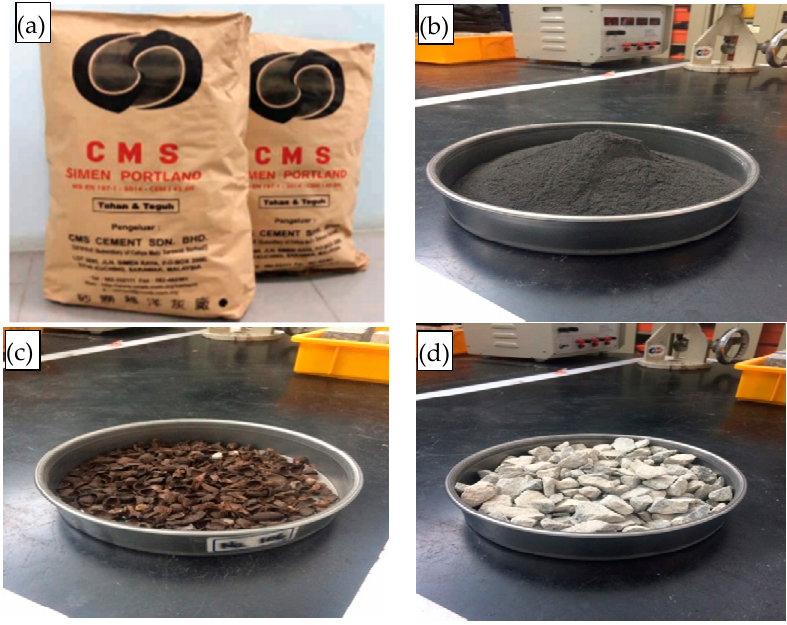
Figure 1. Materials used in the design mix, ( a ) OPC, ( b ) POFA, ( c ) OPS and ( d ) gravels. Table 1. Physical and chemical properties of QD from previous investigations. Particle Size